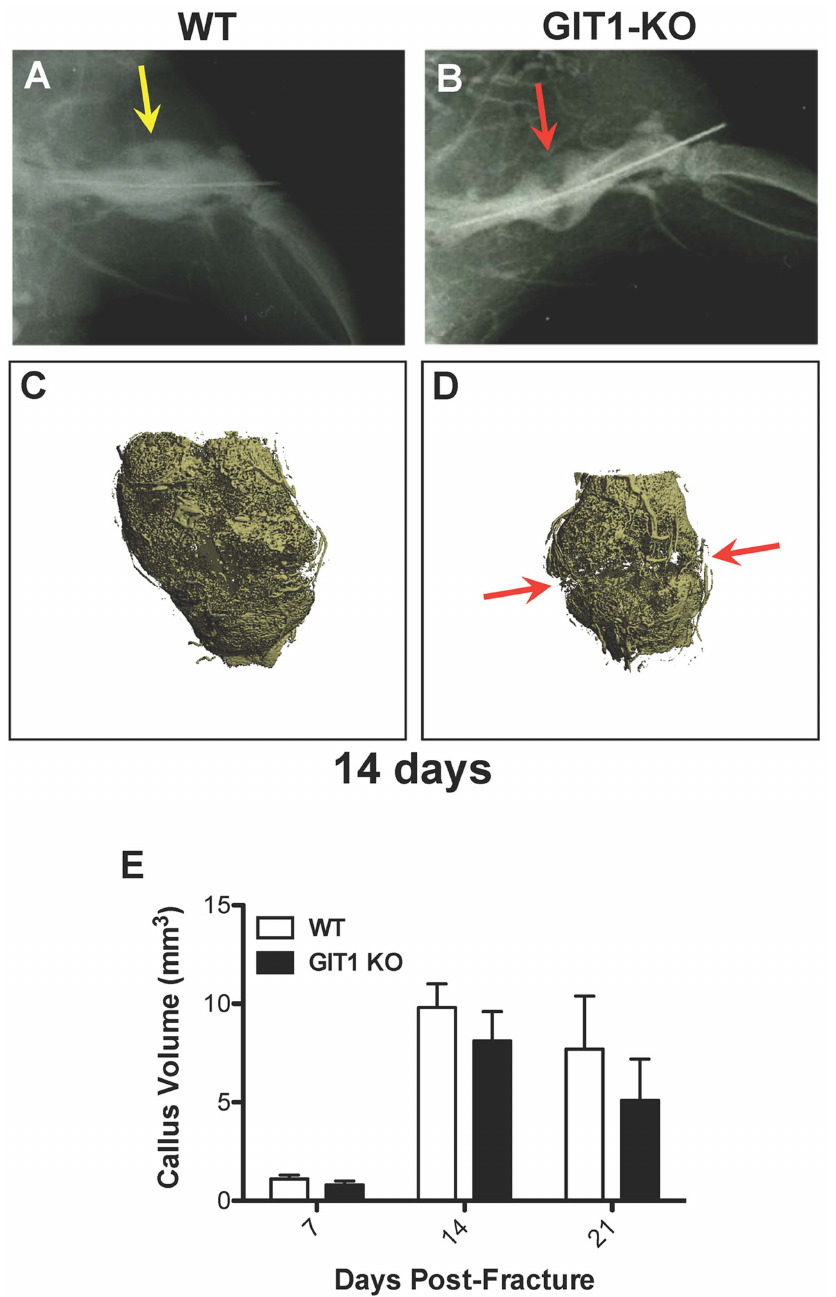
Figure 2. Disjunction persists at 14 days post-fracture in GIT1 KO mice. Femur fractures were induced in 10-week-old WT and GIT1 KO mice. Fractured femora were harvested for analysis at 7, 14, and 21 days post-injury. Radiographs obtained at the 14 day time point consistently revealed radiolucency in GIT1 KO calluses (B, red arrow) compared with calluses from WT mice (A, yellow arrow). This was supported by microCT analysis, which revealed lack of bridging mineral in GIT1 KOs (D, red arrows) compared to a connected shell of mineral in WT controls (C). Further quantification of callus geometry via microCT indicated that there were no differences in mineralized callus volume between WT and GIT1 KO mice (E). Bars represent mean callus volume (mm 3 ) + / 2 SEM (N=3, *p , 0.05).